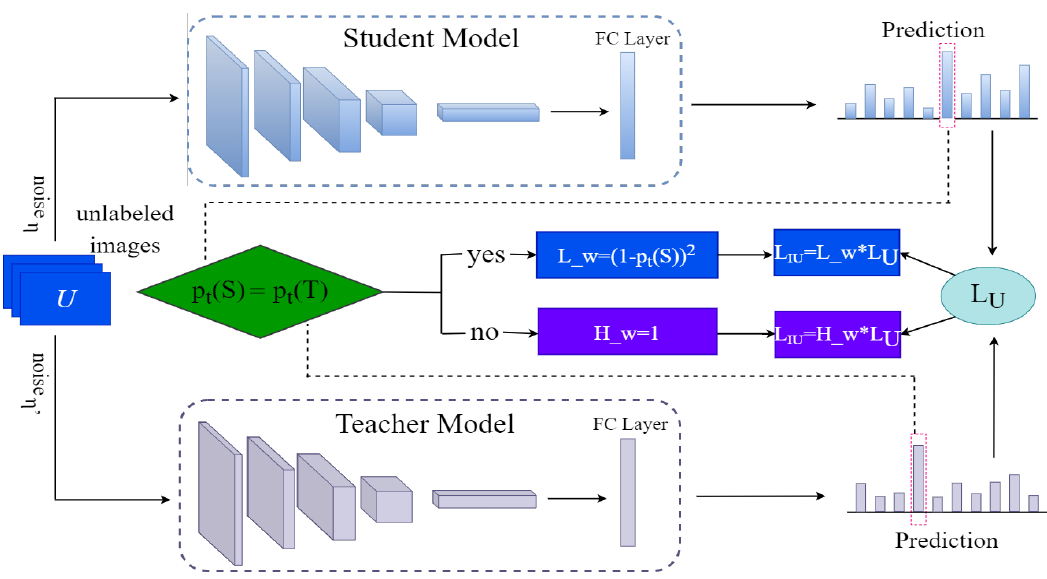
Figure 7. Unsupervised losses for our semi-supervised model.